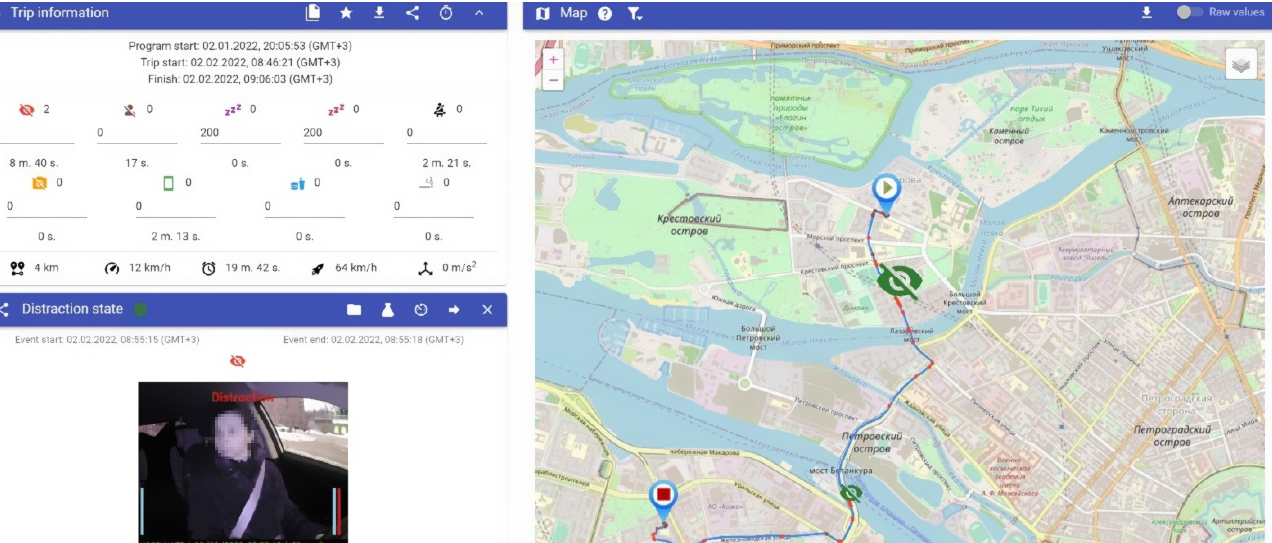
Figure 3. Reference model of operator–computer interaction interface.